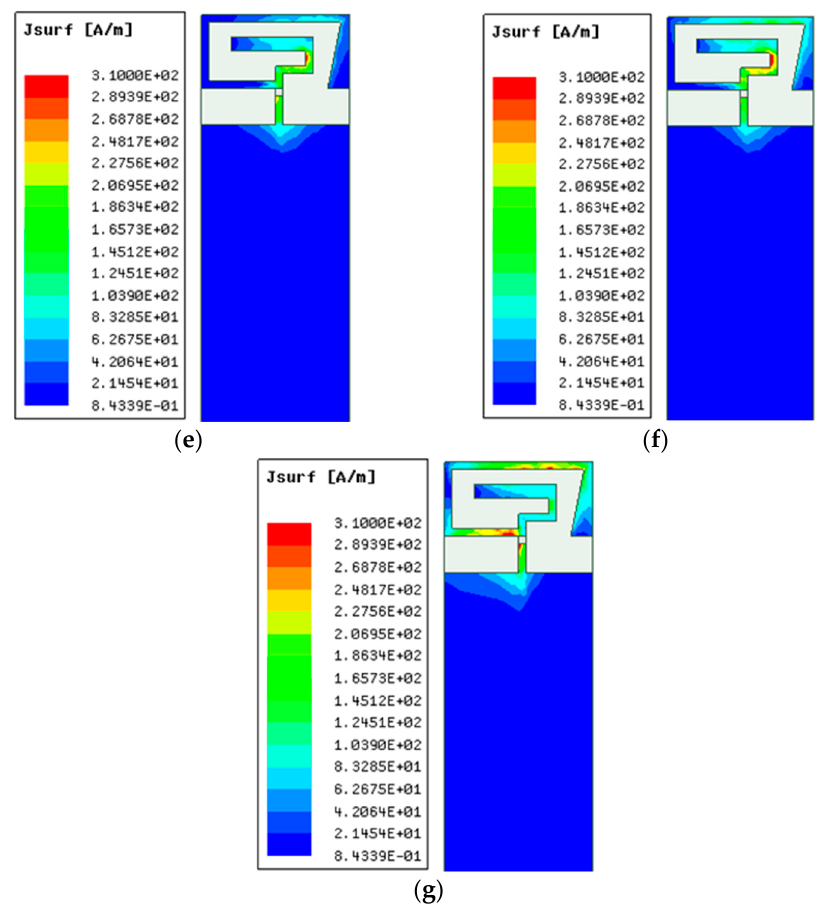
Figure 2. Surface current distribution analysis at: ( a ) 2350 MHz; ( b ) 2450 MHz; ( c ) 5080 MHz; ( d ) 5500 MHz; ( e ) 5890 MHz; ( f ) 6500 MHz; ( g ) 7150 MHz.